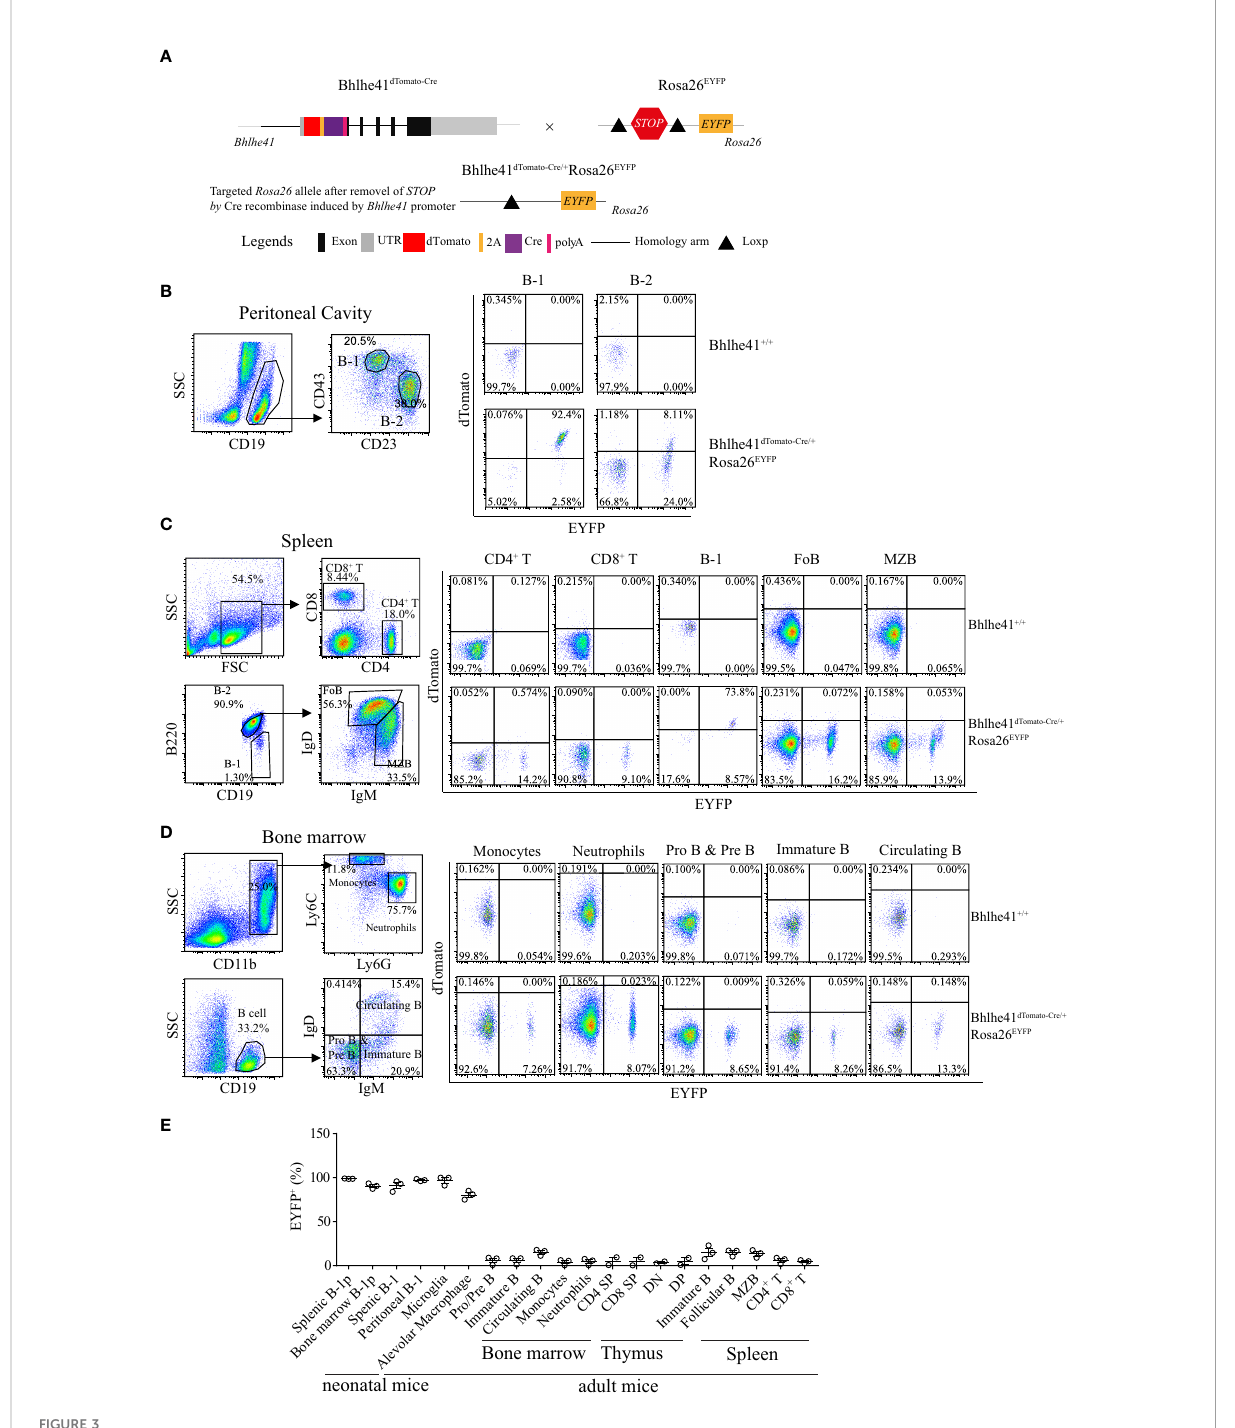
FIGURE 3 Bhlhe41 dTomato-Cre mouse can be used to ef fi ciently target B-1 cells in vivo . (A) Generation of Bhlhe41 dTomato-Cre/ + Rosa26 EYFP mice for analyzing the ef fi cacy and speci fi city of deletion of Loxp - fl anked STOP sequence driven by Cre recombinase induced by Bhlhe41 promoter. Flow cytometric analysis of dTomato and EYFP in (B) peritoneal B-1 and B-2 cells, (C) splenic CD4 + T cells, CD8 + T cells, B-1 cells, follicular B (FoB) cells, and marginal zone B (MZB) cells, (D) neutrophils, monocytes, Pro and Pre B cells, immature B cells, and circulating B cells in the bone marrow from adult Bhlhe41 dTomato-Cre/ + Rosa26 EYFP mice. The gating strategy for each type is illustrated on the left panel. (E) The summary of EYFP + cells in B-1 progenitors (B-1p) from neonatal Bhlhe41 dTomato-Cre/ + Rosa26 EYFP mice at postnatal day 7 and in different immune cells from adult Bhlhe41 dTomato-Cre/ + Rosa26 EYFP mice. CD4 SP, CD4 single positive; CD8 SP, CD8 single positive; DN, double negative; DP, double